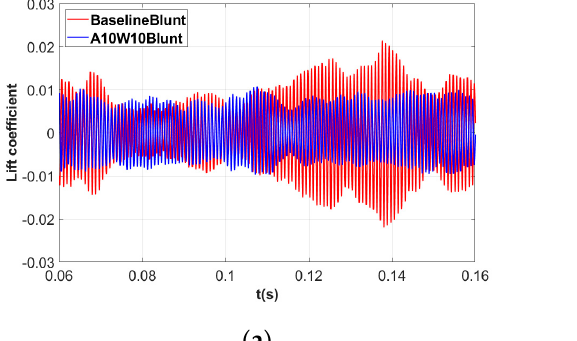
Figure 10. Comparison of the lift coe ffi cient between the baseline airfoil and A10W10 airfoil: ( a ) time domain; ( b ) frequency domain.